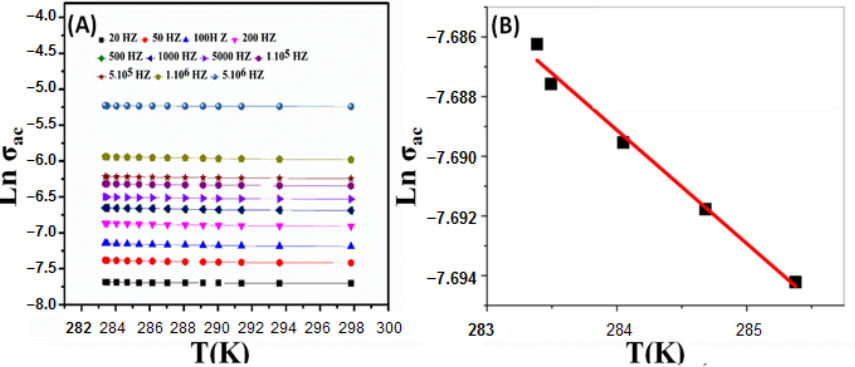
Figure 6. ( A ) variation of AC conductivity, σ ac ( ω ), with the temperature at different frequencies for nanocomposite and ( B ) variation of AC conductivity, σ ac ( ω ), with the temperature at a certain frequency.